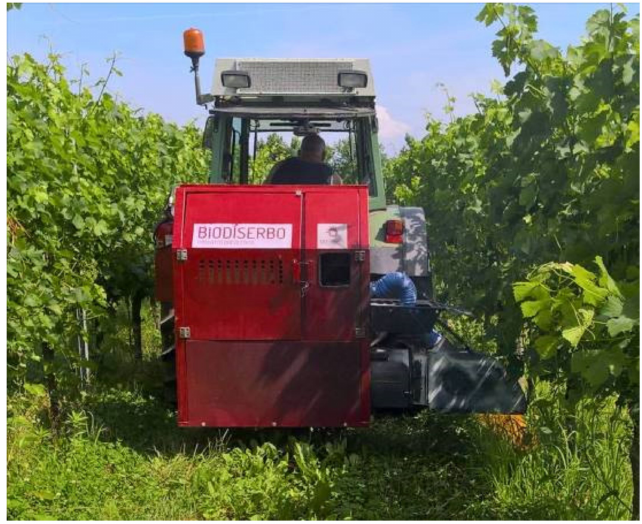
Figure 1. The biomass flamer in the vineyard on 11 June